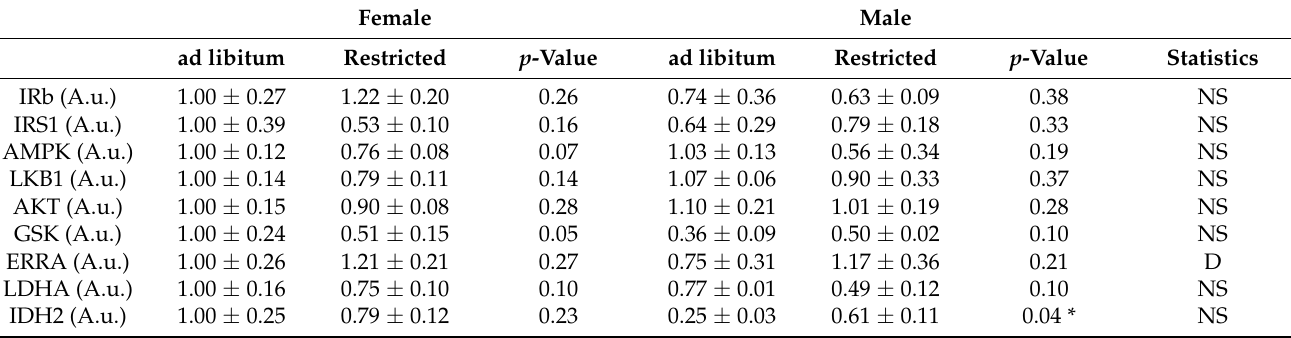
Table 8. Protein levels of several nutrient-sensing pathways markers analyzed by Western Blot. Two-way ANOVA was performed to assess for significance. D indicates diet differences. NS: non- significant. * Statistical differences between calorie restricted and control groups. All data were normalized to ad libitum females.